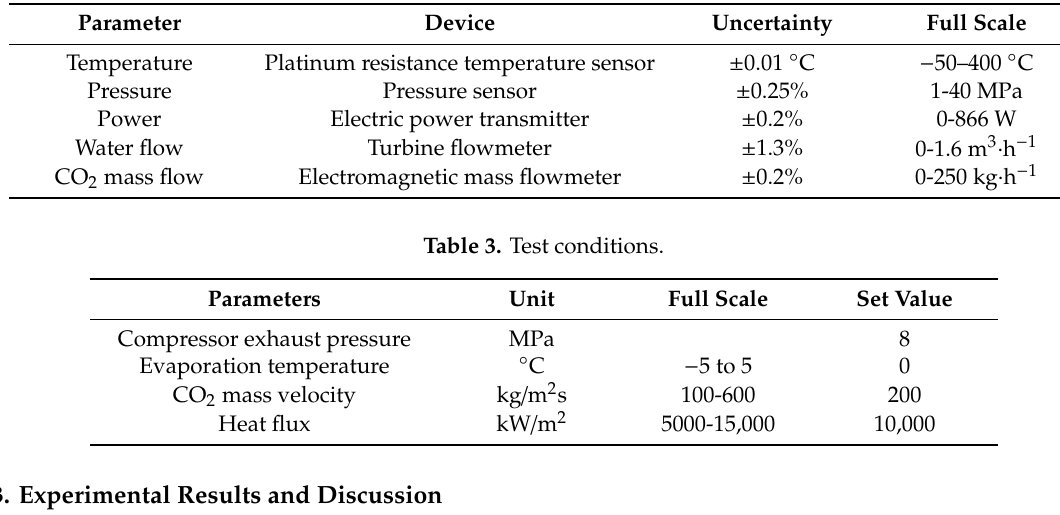
Table 2. Specifications and uncertainties of sensors.